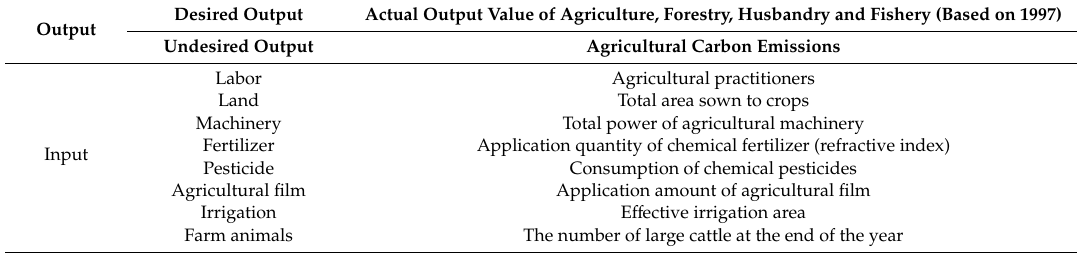
Table 1. Construction of input and output